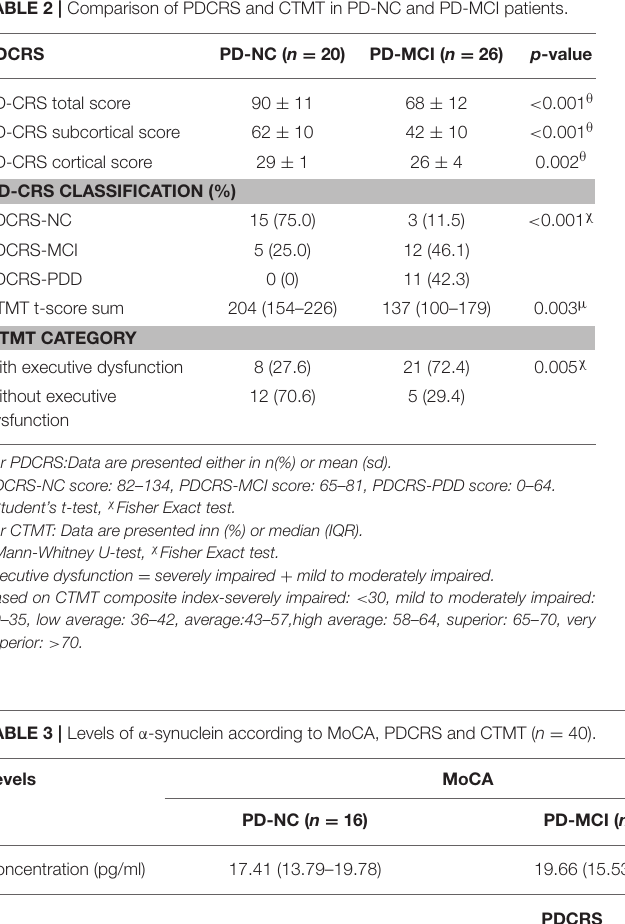
TABLE 2 | Comparison of PDCRS and CTMT in PD-NC and PD-MCI patients.